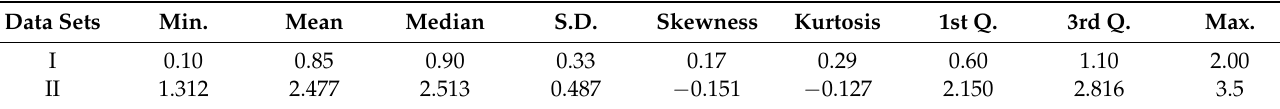
Table 2. Descriptive Statistics for the data set I and data set